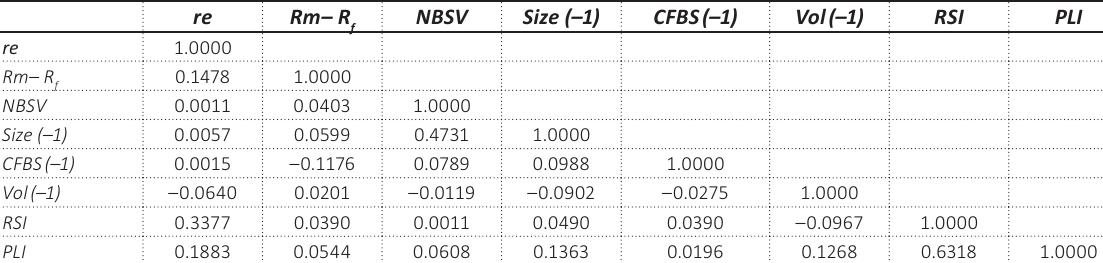
Table 2. Correlation results between pairs of